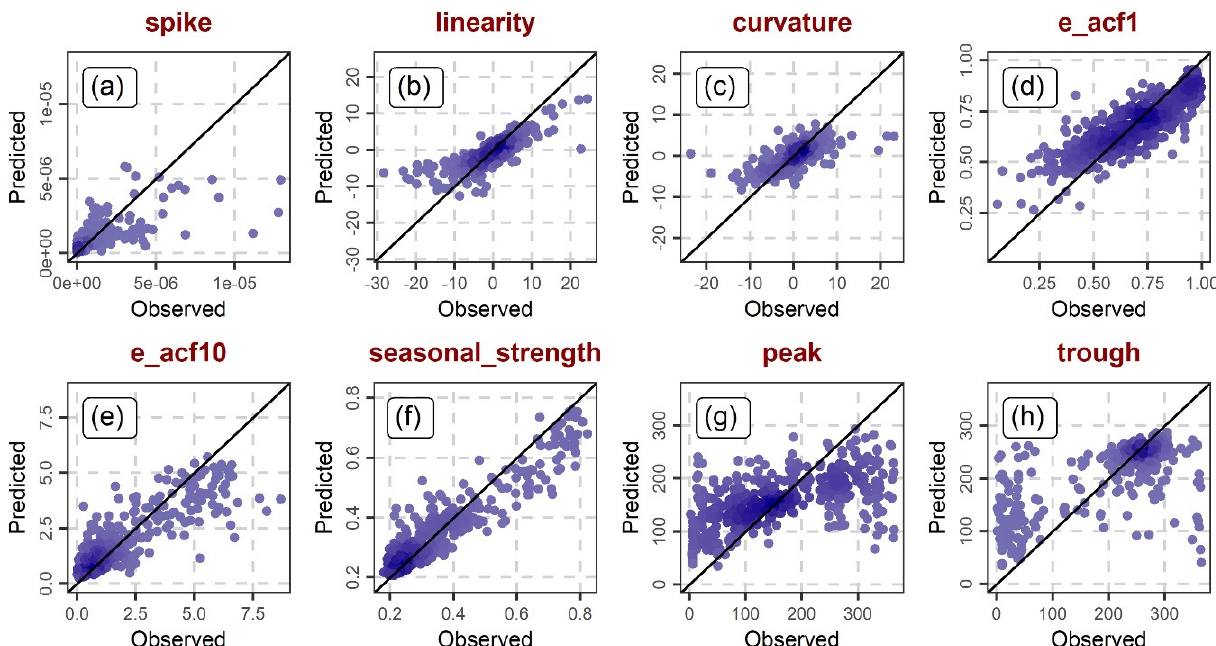
Figure 6. Predicted versus observed daily streamflow features for the 511 investigated catchments when using the total of the static, daily temperature and daily precipitation features as predictor variables under a 10-fold cross validation setting (part 2). The displayed feature abbreviations are explained in Section 2.2.